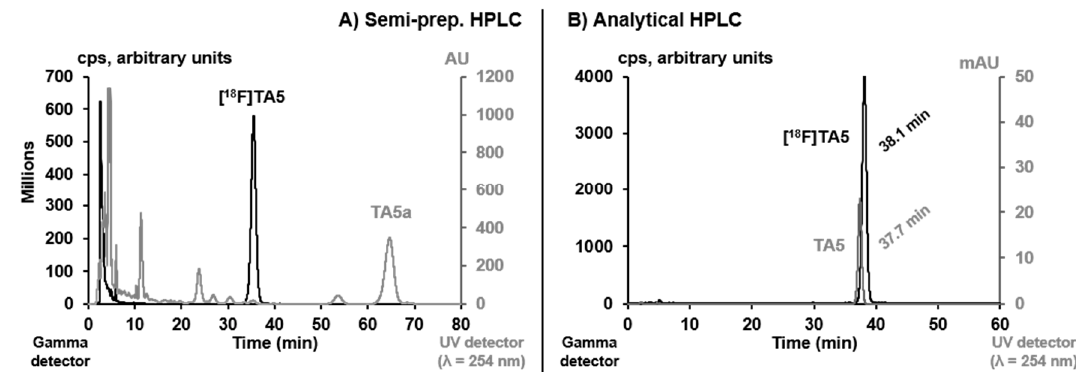
Figure 2. ( A ) Semi-preparative HPLC profile of the crude reaction mixture for isolation of [ 18 F] TA5 (column: Reprosil-Pur C18-AQ, 250 × 10 mm, particle size: 10 µ m; eluent: 50% MeCN/20 mM NH 4 OAc aq. ; flow: 5 mL/min); ( B ) analytical HPLC profile of the formulated